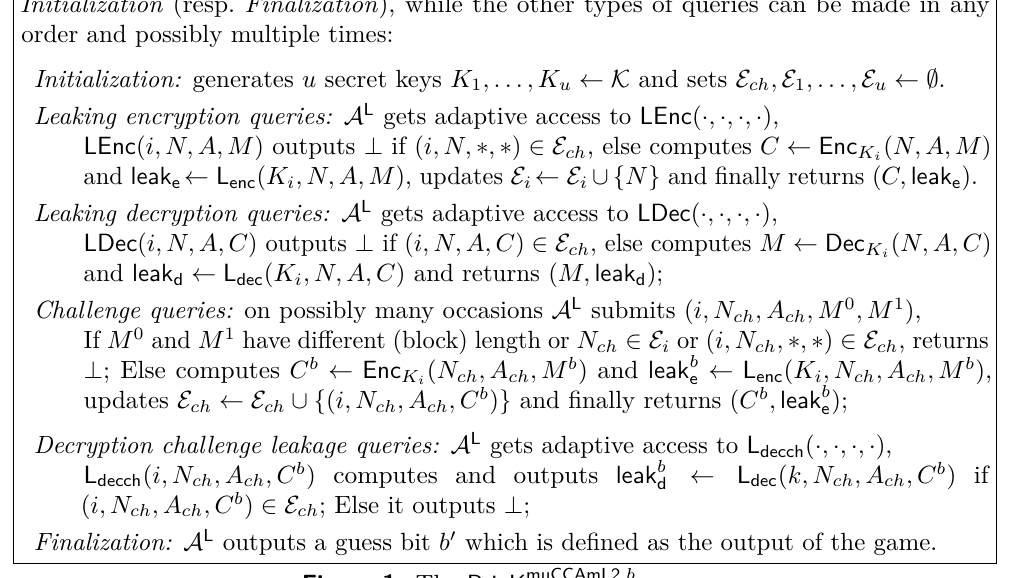
Figure 1: The PrivK muCCAmL2 ,b A , AEAD , L ,u